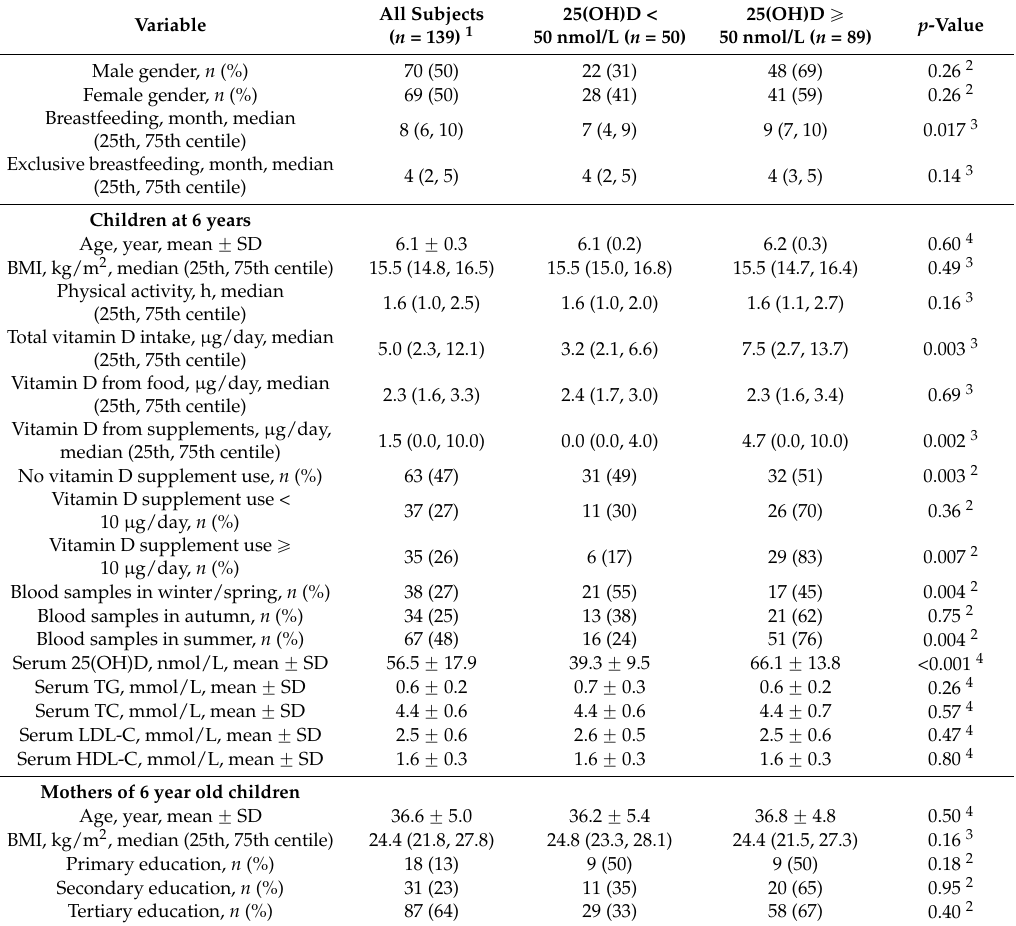
Table 1. Characteristics of eligible subjects.